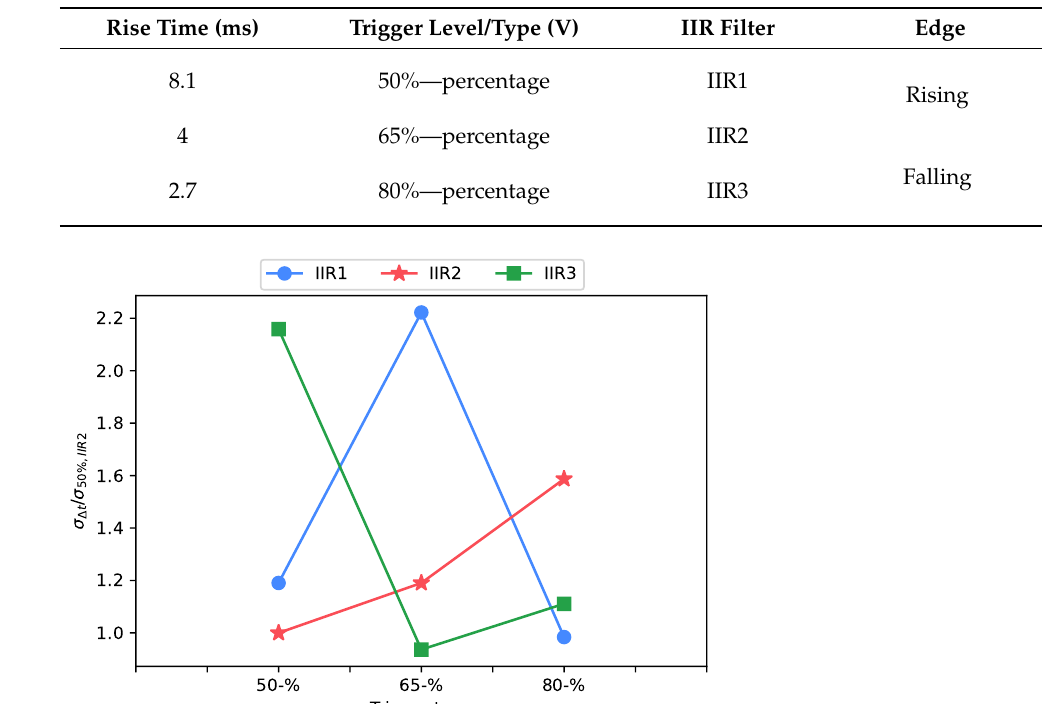
Figure 9. Standard deviation of arrival time shift: test case at 4 µ s rise time, 1.5 V of full scale